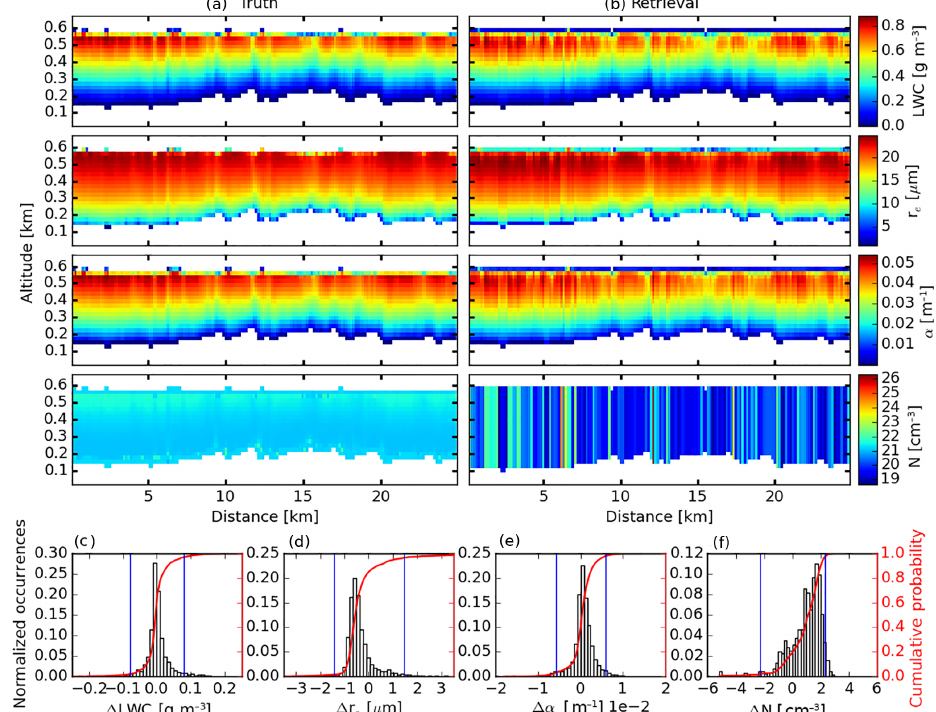
Figure 4. True (a) and retrieved (b) microphysical and optical properties corresponding to the synthetic signal shown in Fig. 3 as a function of vertical and horizontal distance. From top to bottom: liquid water content, effective radius, optical extinction coefficient, and number concentration. The last row ( c–f): histograms of the differences between the true and the retrieved cloud properties (truth minus retrieved). The spread of the distribution is indicated by the blue vertical lines that mark the interval within which 95% of the total occurrences are found. The right y axes of the four histograms are all identical and correspond to the cumulative distributions shown by the red curves.